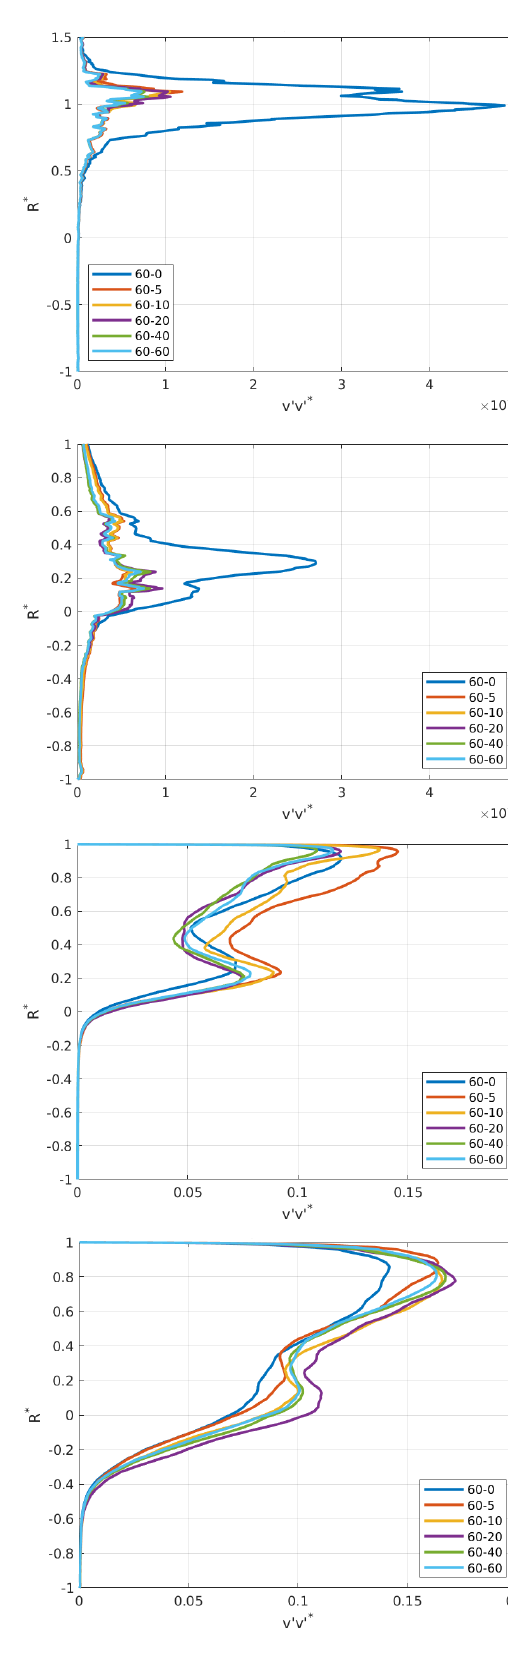
Figure 11. Vertical profiles of 𝑣 (cid:4593) 𝑣 (cid:4593)∗ at different cross-sections.